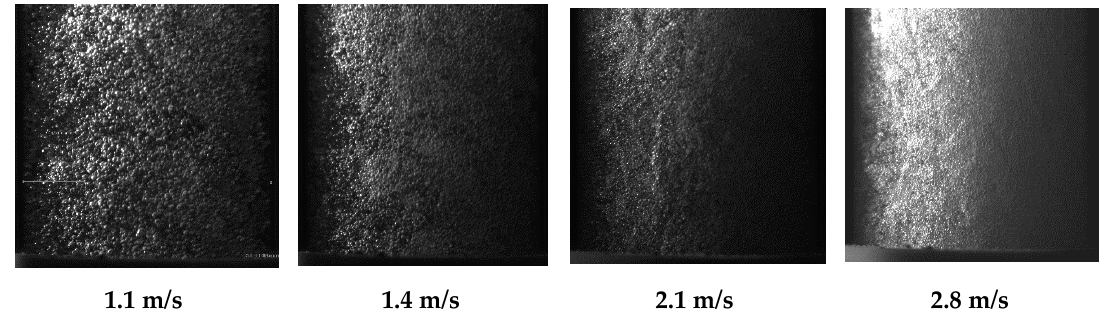
Figure 11. HSC images of the aerated water streams in the CLR at different flow velocities. The presented images clearly depict a reduction in the bubble size as the stream flowrate grows.